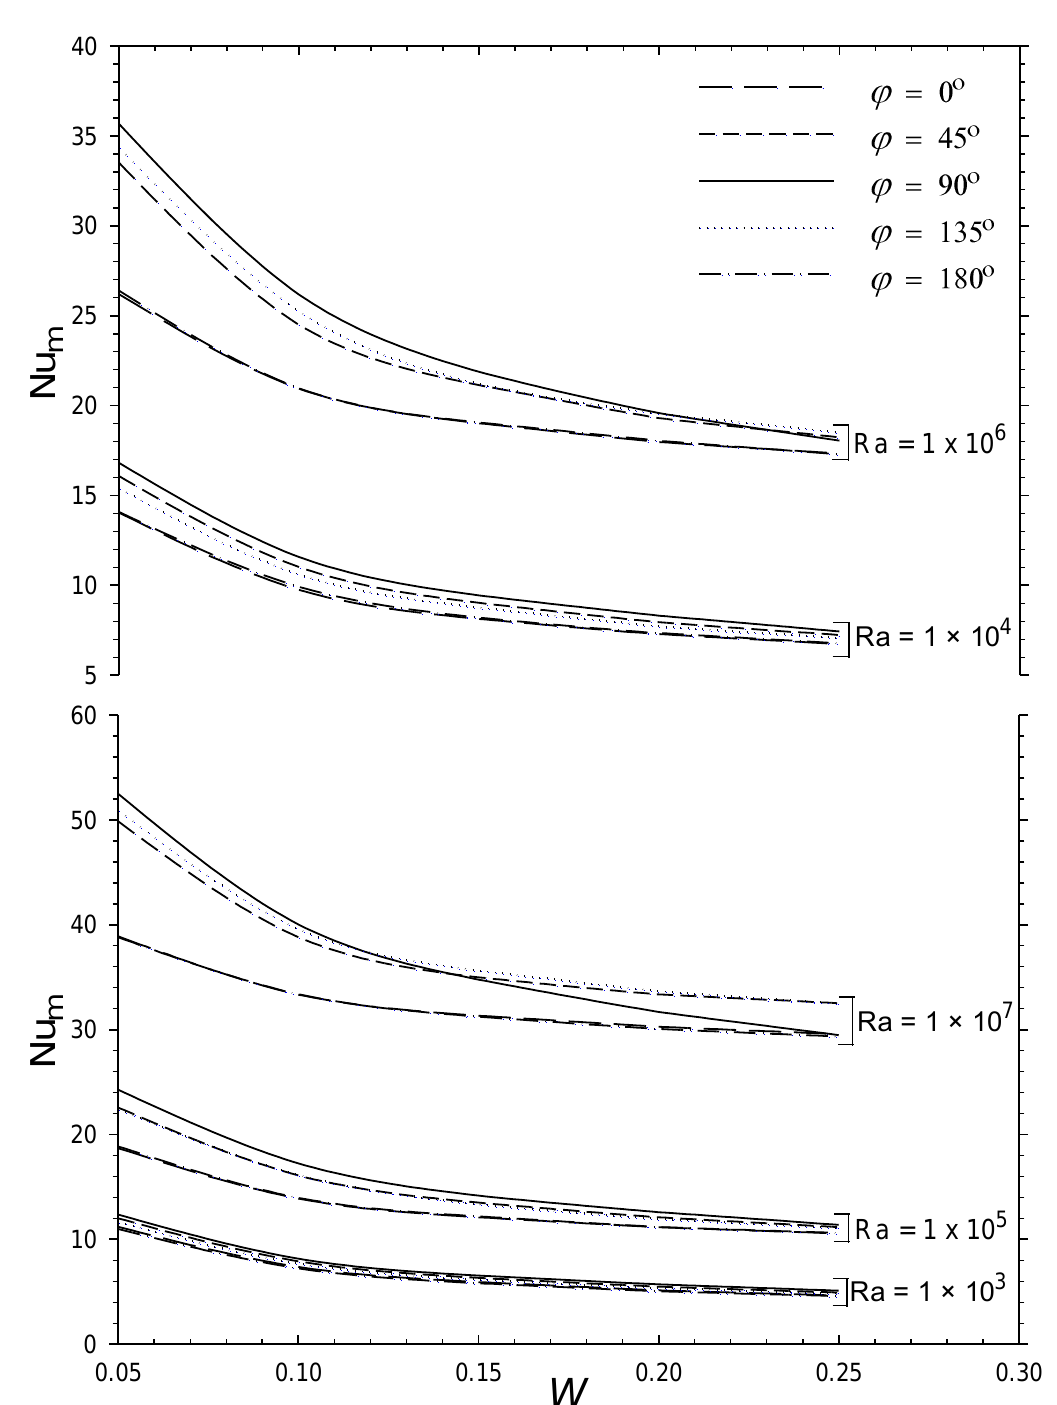
Figure 6. Variations in mean Nusselt number with dimensionless width, W , for different values of the heat flux Rayleigh number, Ra *, and positions, φ , for all surfaces of the slender cuboid.